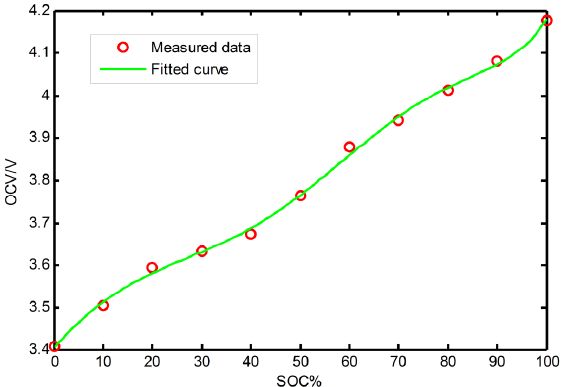
Figure 3. The sixth-order polynomial fitted curve between OCV and SOC. T able 1. Identified parameters of second ‐ order RC ECM.